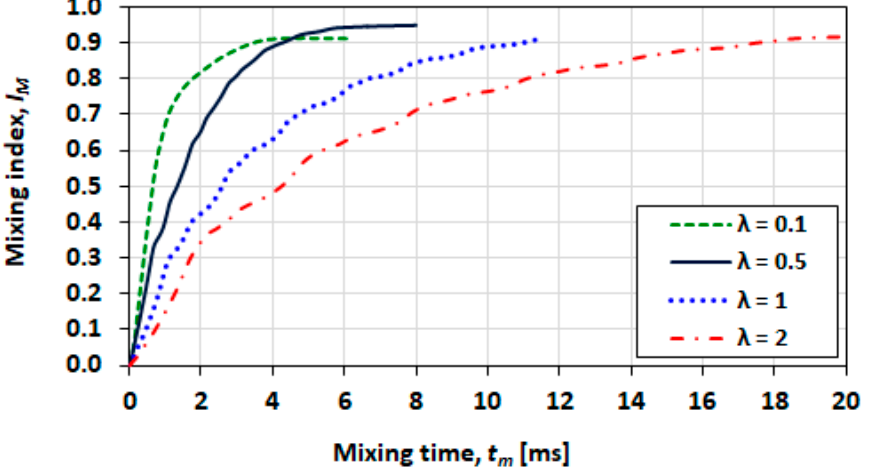
The mixing index plots for various viscosity ratios at Ca = 0.21 are given in Figure 30.